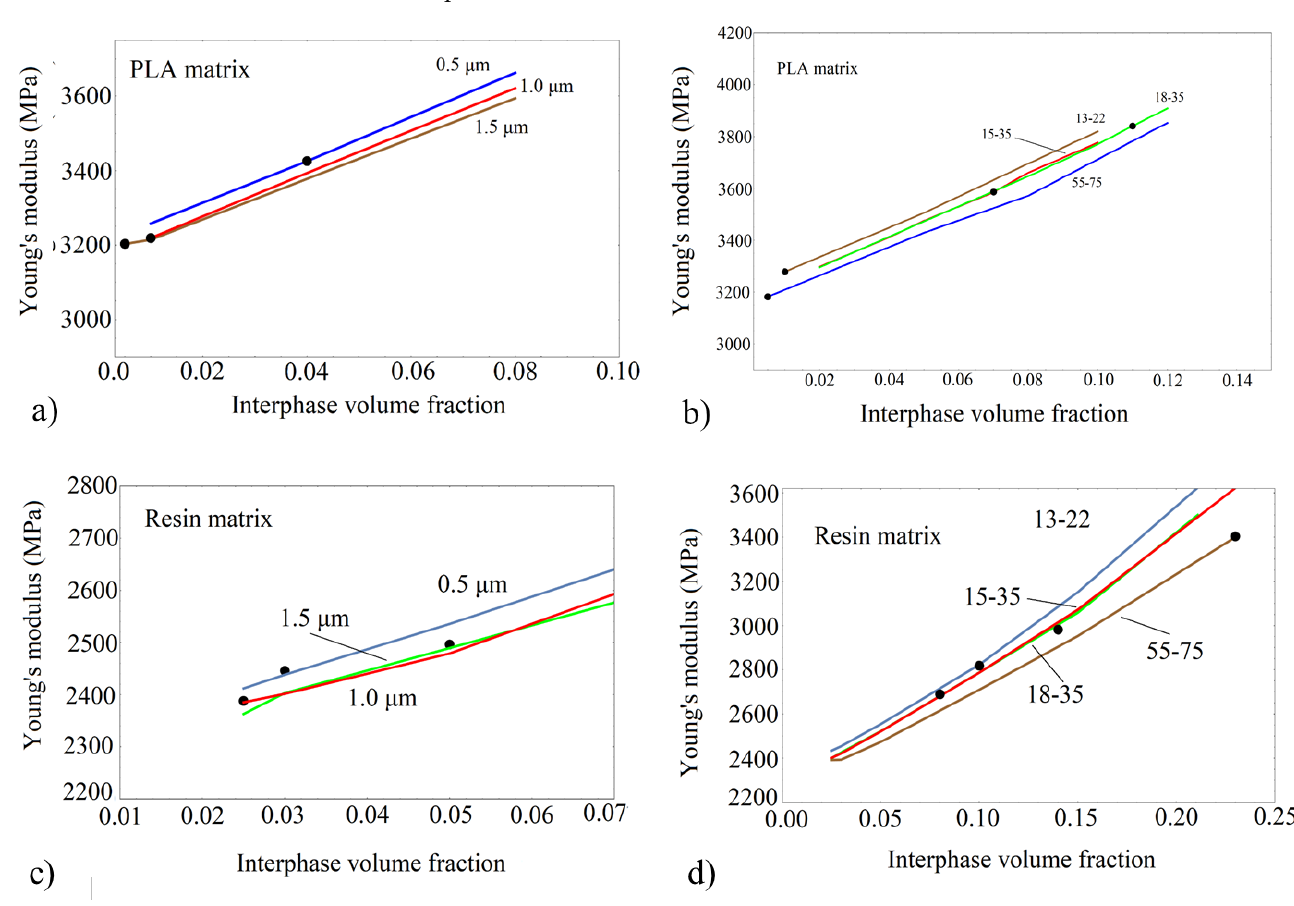
Figure 9. Young’s modulus by FE analysis with varying relative interphase volume fraction for all SiO 2 composites examined. Lines: Finite Element simulation; Points: Experimental data ( a ) PLA/SiO 2 with particle’s diameter at the micro-scale, ( b ) PLA/SiO 2 with particle’s diameter at the nano-scale, ( c ) Resin/SiO 2 with particle’s diameter at the micro-scale, ( d ) Resin/SiO 2 with particle’s diameter at the nano-scale.